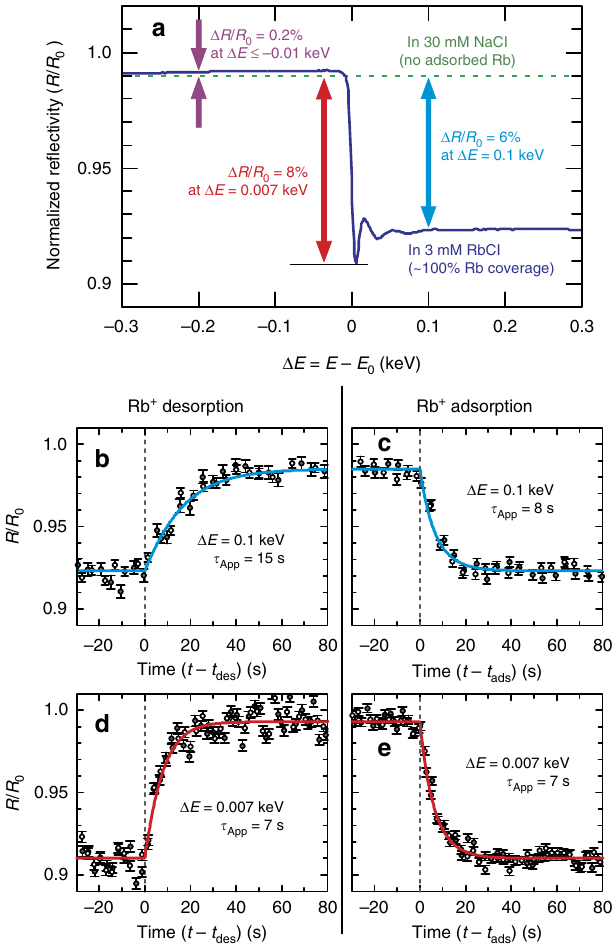
Figure 2 | Real-time X-ray reflectivity during Rb þ /Na þ exchange at the muscovite mica (001)–water interface at a fixed q . ( a ) RAXR spectrum of muscovite (001) surface at q ¼ 0.488Å (cid:2) 1 in 3mM RbCl compared with that in 30mM NaCl (ref. 22). The reflectivity ( R ) is normalized to the non-resonant reflectivity ( R 0 ) calculated using the best-fit model of the non-resonant XR data for the mica–RbCl system 22 . The purple, red and blue arrows indicate the relative changes at three different photon energies ( E ) near the X-ray absorption K-edge energy of Rb ( E 0 ¼ B 15.2keV). ( b – e ) The temporal changes in reflectivity measured at D E ¼ 0.1keV (and 0.007keV) during Rb þ desorption and adsorption, including duplicate data (open and solid circles). One s.d. error bars are calculated on the basis of the counting statistics 43 . The solid curves are calculated from the best-fit first-order exchange equations where t App is the apparent time constant (Supplementary Note 3). In each plot, the time of injection of the exchanging solution (either t des or t ads for Rb þ desorption or adsorption, respectively) is indicated by a dashed vertical